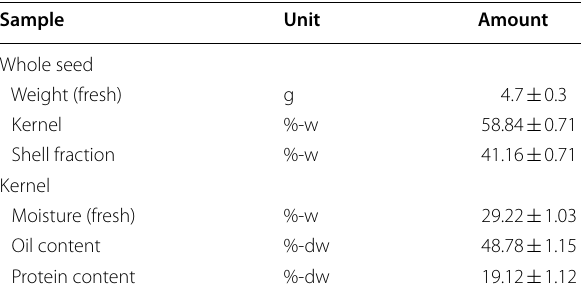
Table 1 Composition of rubber seed, as percentages, based on dry weight (dw) or wet weight (w)